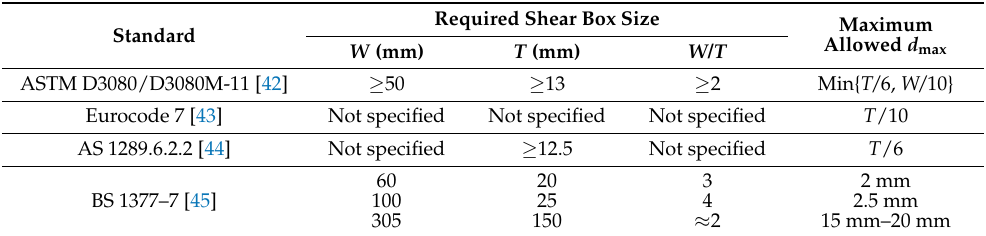
Table 1. Standards of direct shear tests regarding maximum particle size ( d max ), specimen width ( W ) and thickness ( T